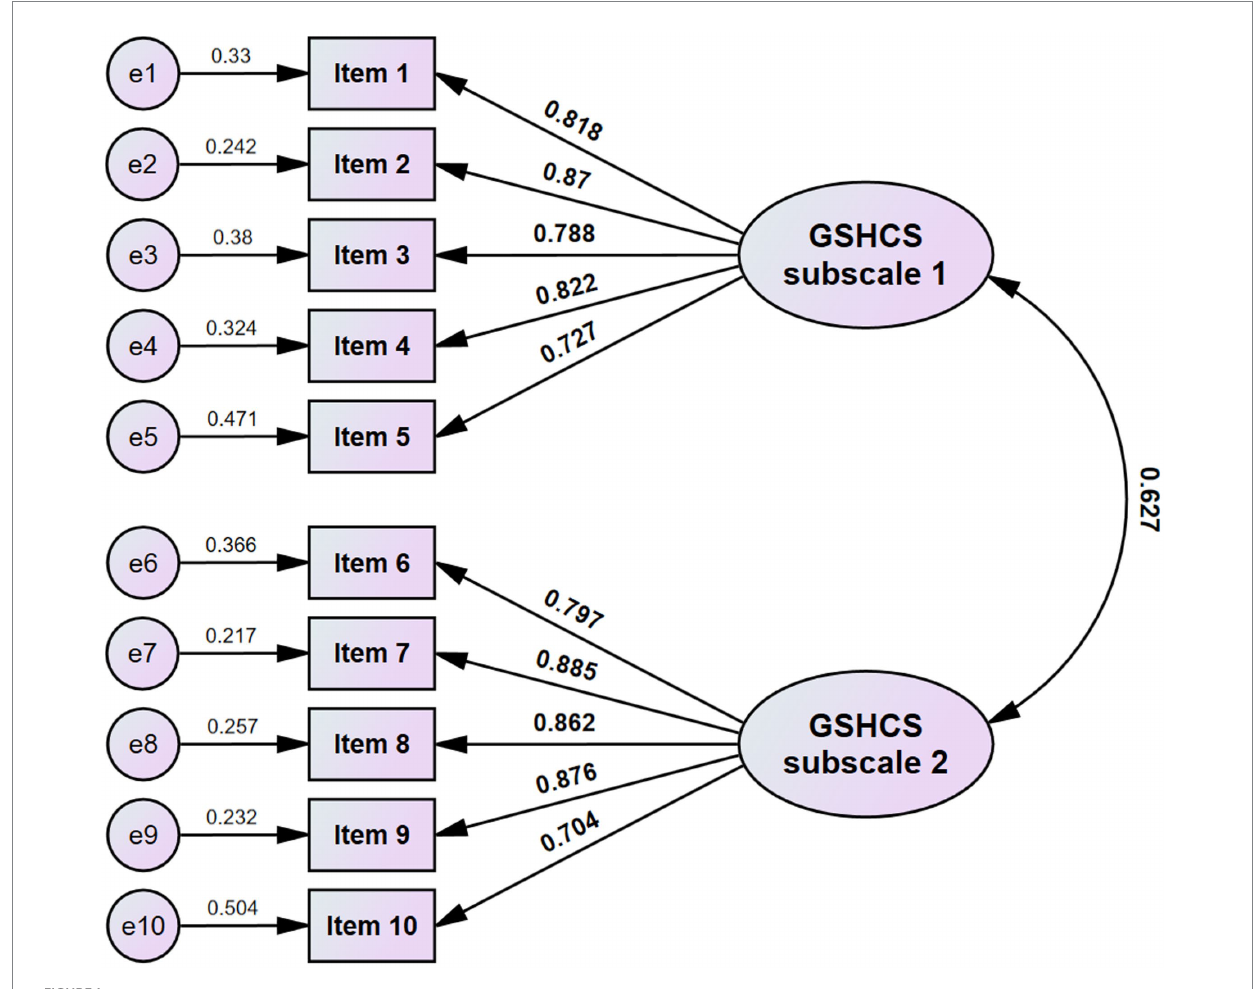
FIGURE 1 Factor structure of 10-item Korean version of the